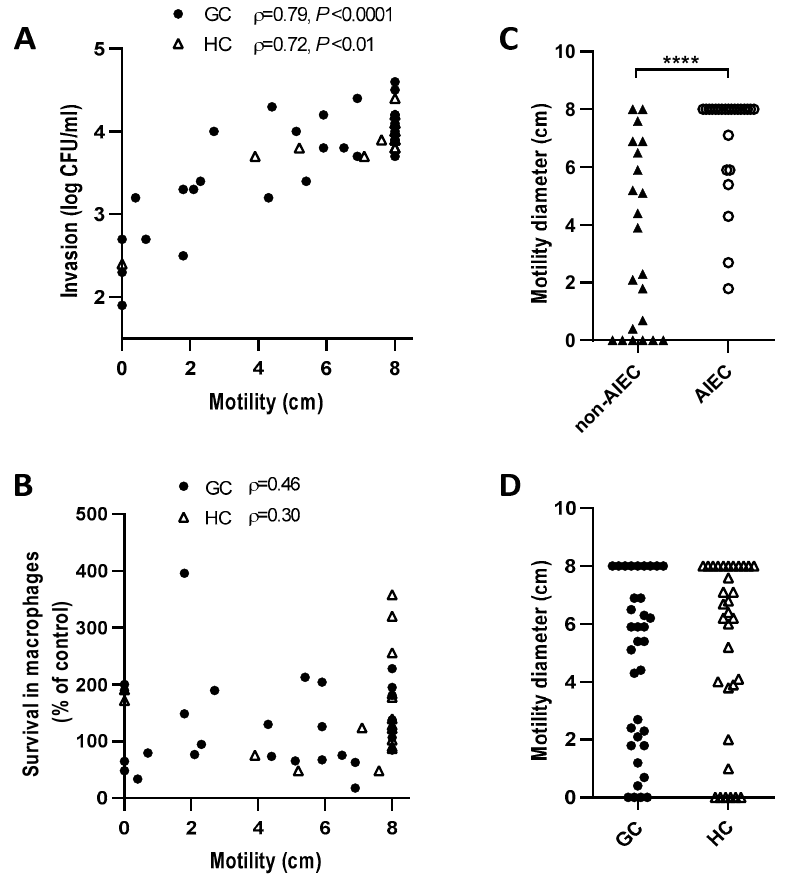
Figure 3. Relationship of motility to the invasion of epithelial cells and intracellular survival in macrophages. Motility versus ( A ) epithelial cell invasion, ( B ) survival in macrophages, ( C ) AIEC pathotype, and ( D ) disease. Motility was determined on soft agar. The correlation between Caco-2 invasion or survival in macrophages and motility was tested by the Spearman rank